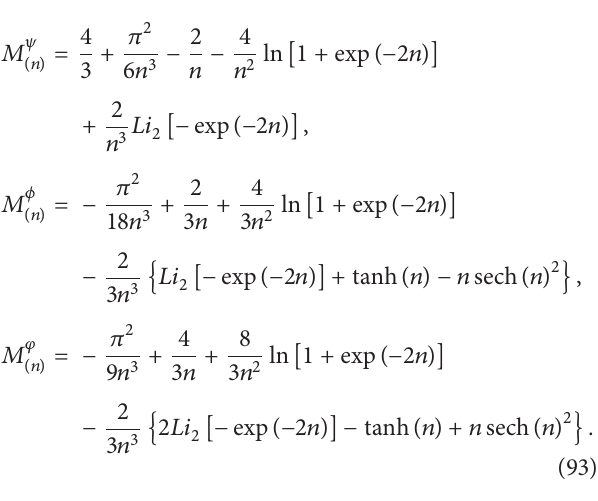
between parenthesis is in correspondence with Figures